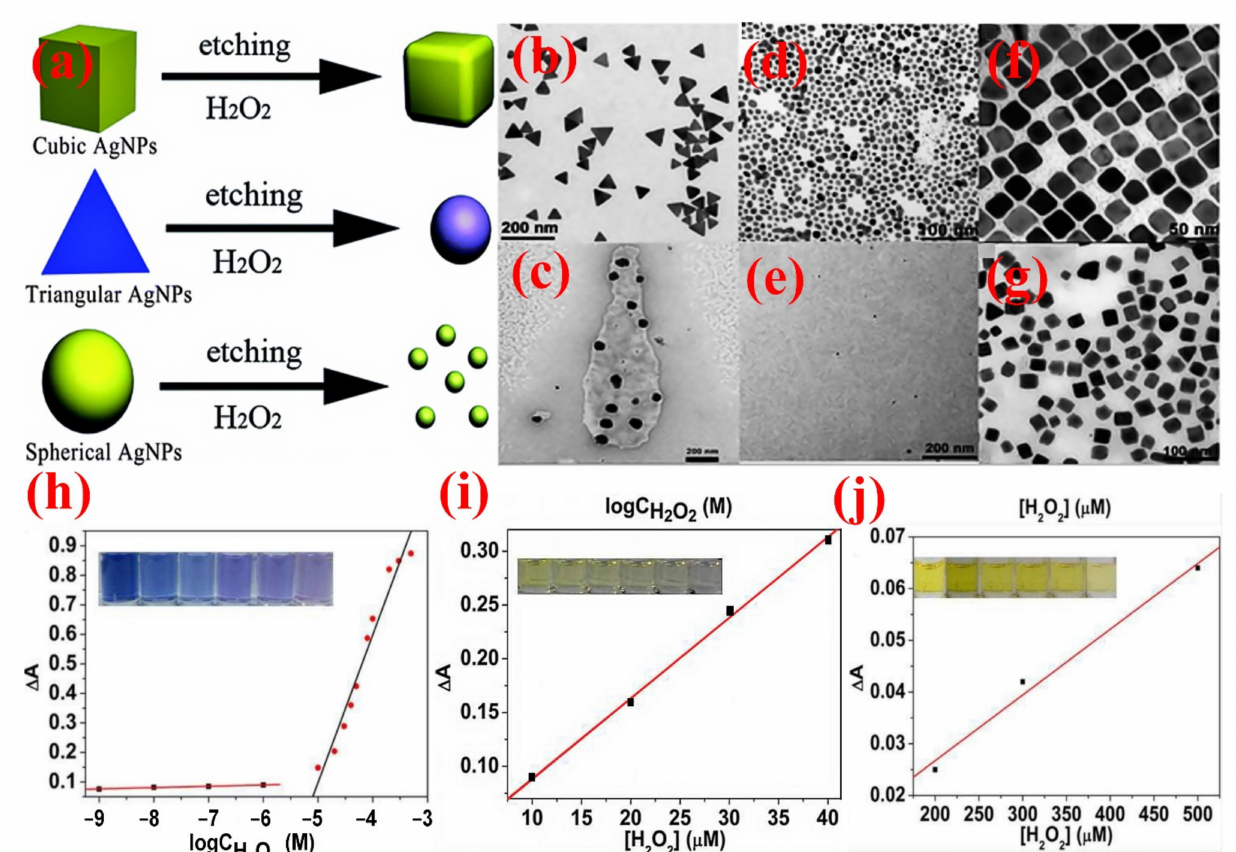
Figure 13. ( a ) Scheme for Ag NPs-H 2 O 2 scheme for H 2 O 2 sensing. TEM image of Ag NPs before etching, ( b ) triangular ( d ) spherical, and ( f ) cubic. TEM images of Ag NPs after etching, ( c ) triangular, ( e ) spherical, and ( g ) cubic. Plots of SPR peak change of ( h ) triangular, ( i ) spherical, and ( j ) cubic Ag NPs vs. concentrations of H 2 O 2 . (Inset the color change of Ag NPs in the presence of H 2 O 2 with various concentrations), copied with permission from Ref. [167], Royal Society of Chemistry,